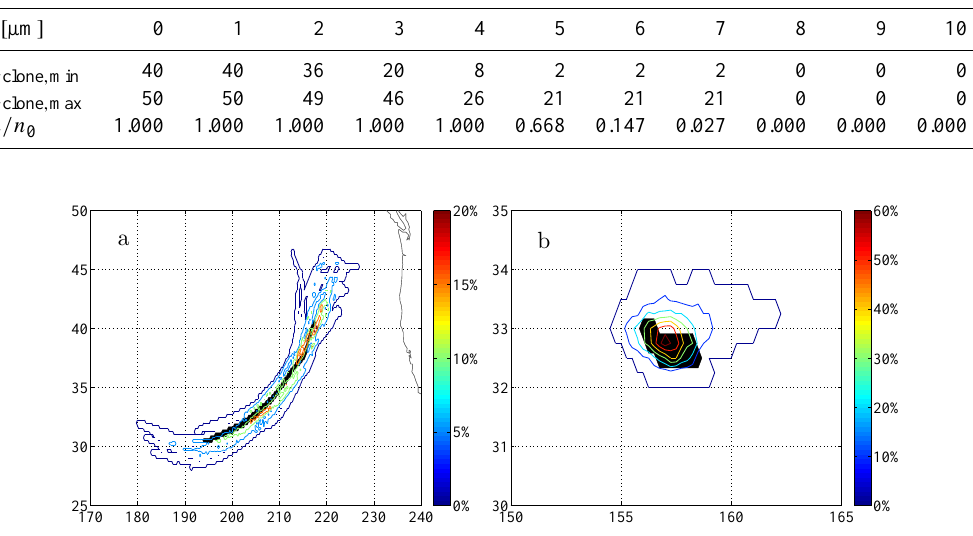
Fig. 5. Colored contours (at 2 , 5 , 10 , 15 , 20 % in a , and at 2 %, 10 %, 20 %, ..., 60 % in b ) indicate the percentage of the ensemble dispersion simulations predicting a “concentration” above the threshold c th = 0 . 0011% after 2.5 days in a 0 . 25 ◦ × 0 . 25 ◦ (a) air column for r = 1µm and (b) cell for r = 10µm “deposited” particles. Black cells refer to the results based on the deterministic forecast where the concentration is above c th . Axis labeling corresponds to geographical coordinates in degree.